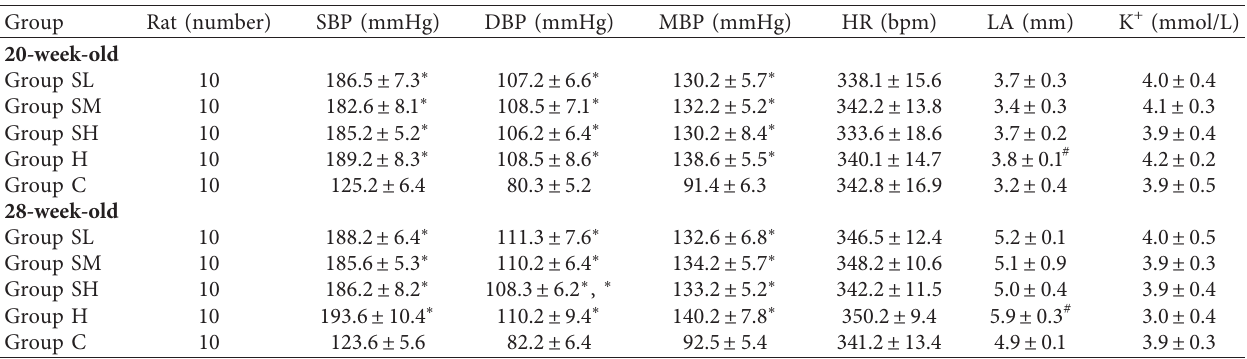
Table 1: Comparison of blood pressure, heart rate, LA size, and serum potassium in rats (M ± SD).